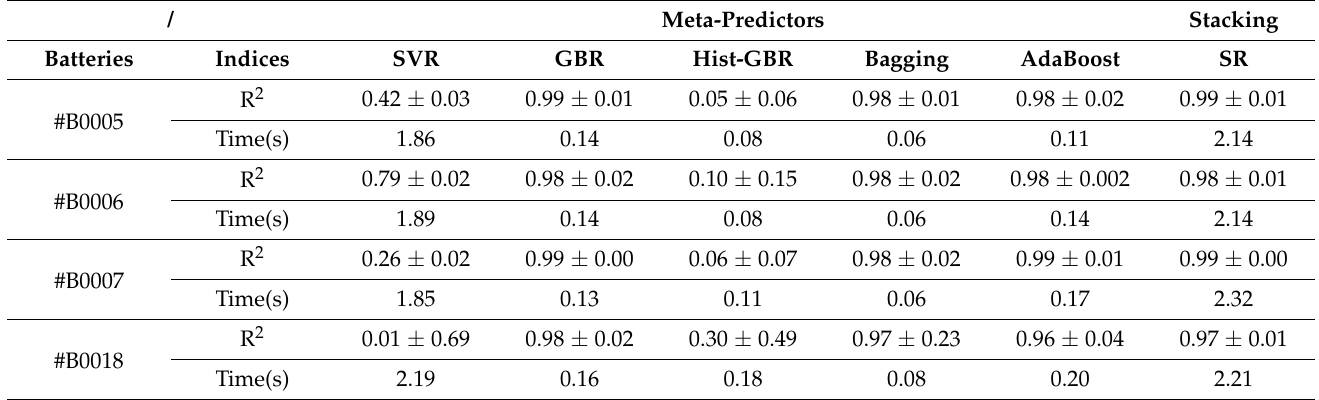
Table 4. The prediction performance of the single predictor and SR models for batteries #5, #6, #7, and #18, respectively.